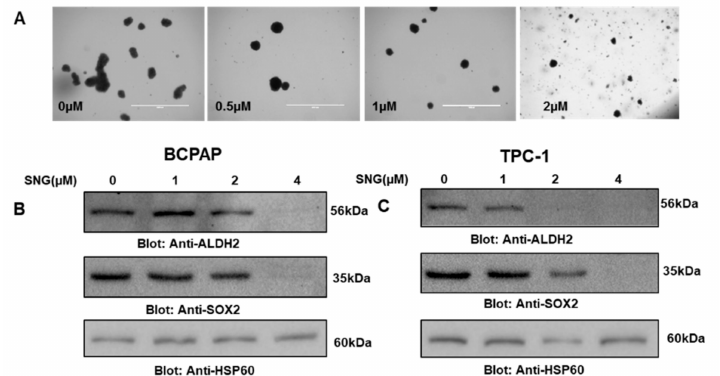
Figure 8. ( A ) SNG-treatment inhibited thyrosphere formation of PTC cells. BCPAP cells were grown and treated in ultralow attachment plates with 0 µ M or 0.5 µ M, 1 µ M and 2 µ M of SNG for 7 days, and images of thyrospheres were taken on day 7 using an EVOS FLc cell imaging system from Invitrogen (Thermo Fisher Scientific) at a magnification of 4 × (scale bar 1000 µ m). ( B ) BCPAP and ( C ) TPC-1 cells spheres were grown and treated in ultralow attachment plates with 0 µ M, 1 µ M, 2 µ M and 4 µ M of SNG for 3 days, followed by cell lysis and Western blotting with antibodies against ALDH2, SOX-2 and